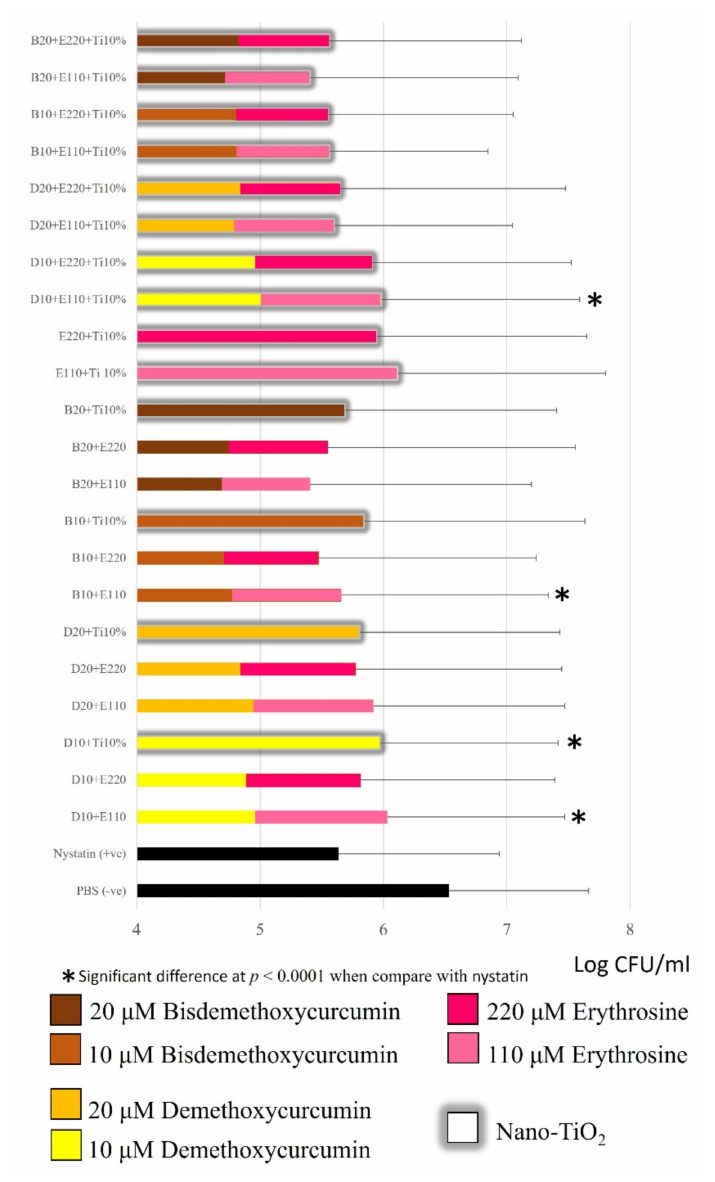
Figure 6. Comparison of Candida albicans numbers in log 10 CFU after treatment with test photo- sensitizers at 48 h using a drop plate assay. All photosensitizers were incubated for 15 min prior to blue light (395–480 nm) irradiation 72 J/cm 2 . Phosphate buffer saline was set as the negative control and nystatin oral suspension (1:100,000 units) was set as the positive control.